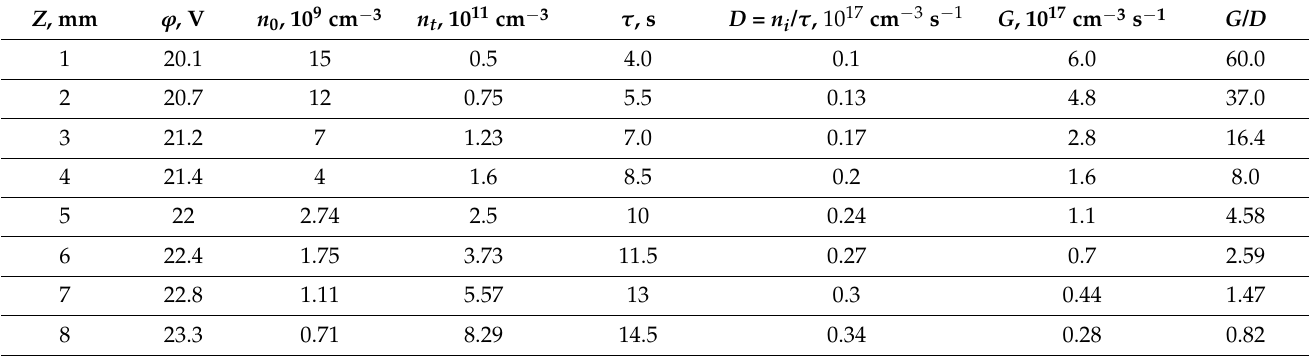
Table 1. Axial distribution of plasma parameters at P He = 2 Torr and a discharge current of 0.5 A.